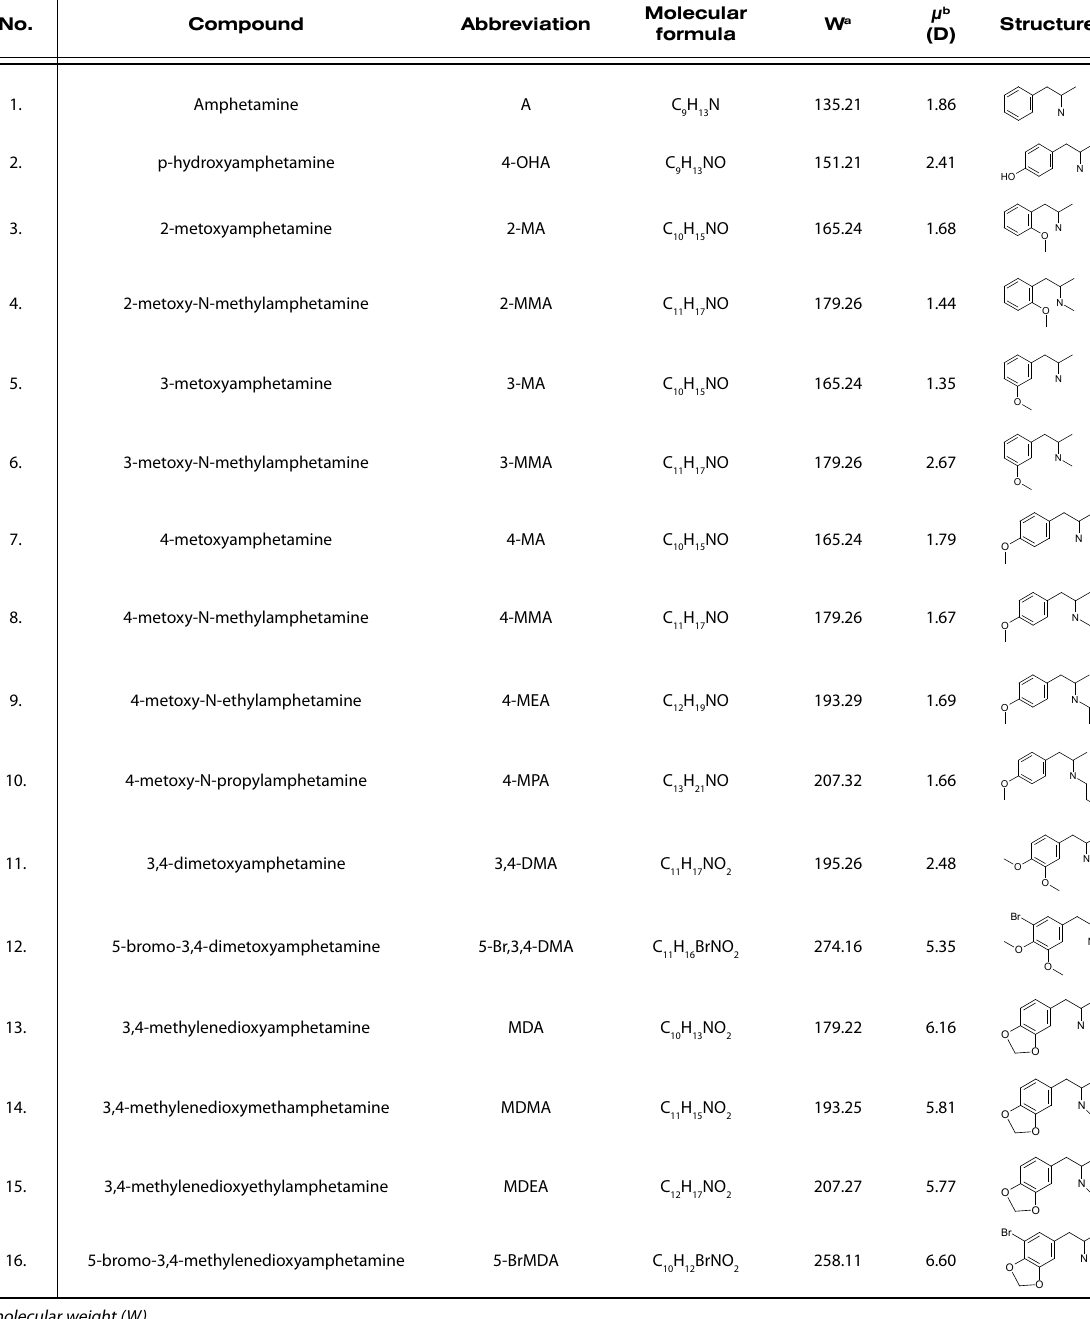
Table 1. Structures, molecular data, applied abbreviations and numbers of amphetamine derivatives. No. Compound Abbreviation